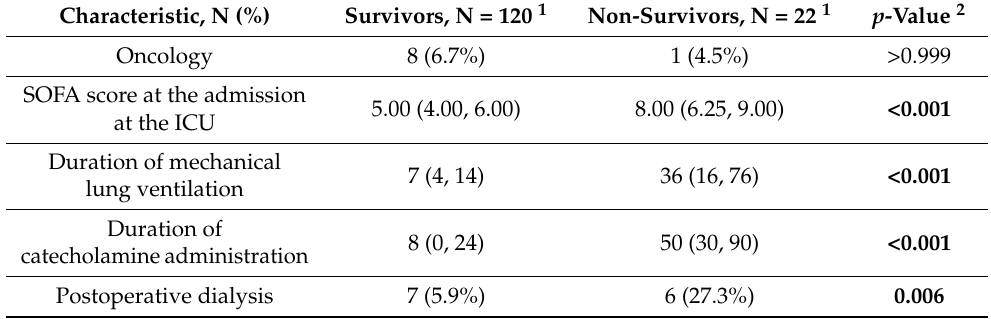
Table note: 1 n (%); Median (IQR); 2 Fisher’s exact test; Wilcoxon rank-sum test; Pearson’s Chi-squared test; CoNS—coagulase-negative staphylococci; ICU—intensive care unit; BMI—body mass index;